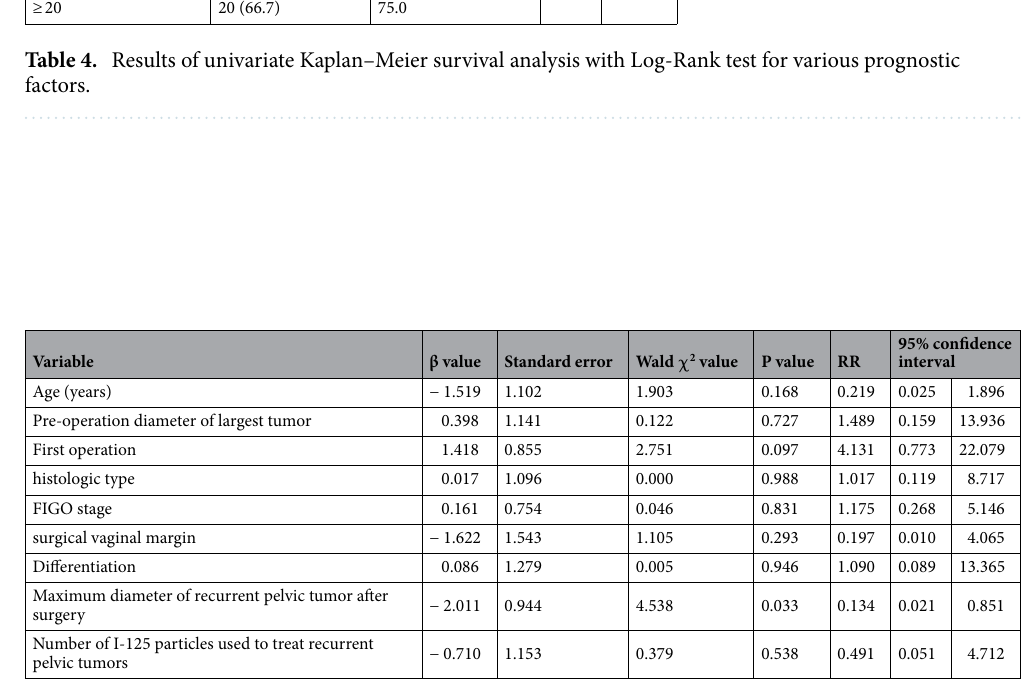
Table 5. Multivariate analysis of prognostic factors with Cox proportional hazards model.